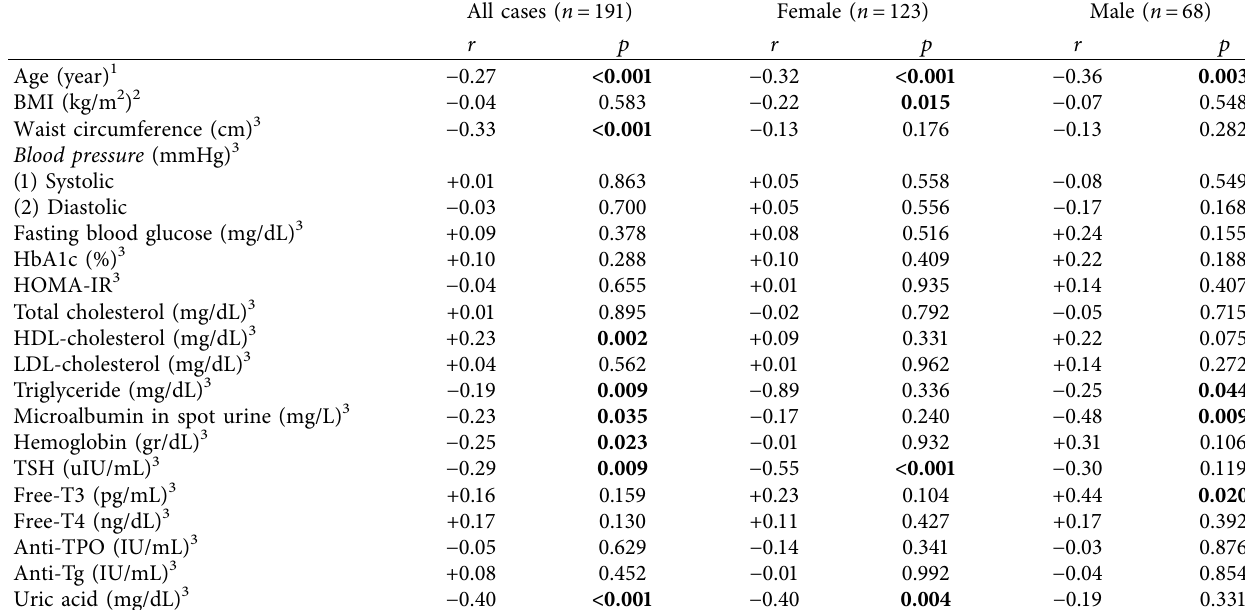
Table 3: The partial correlation coefficients between the estimated-GFR (log gender subgroups.